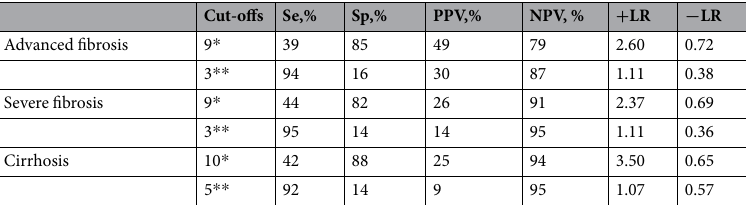
Cut-offs Se,% Sp,% PPV,% NPV, % + LR − LR 9 * 39 85 49 2.60 0.72 0.38 0.69 0.36 10 * 42 88 25 3.50 0.65 92 95 1.07 0.57 Table 4. Diagnostic thresholds of eLIFT for liver fibrosis and cirrhosis. eLIFT, the easy Liver Fibrosis Test; Se, sensitivity; Sp, specificity; PPV, positive predictive value; NPV, negative predictive value; + LR, positive likelihood ratio; − LR, negative likelihood ratio; Cut-offs * were obtained by maximizing Youden index (sensitivity + specificity − 1); Cut-offs ** were established by obtaining a sensitivity of at least